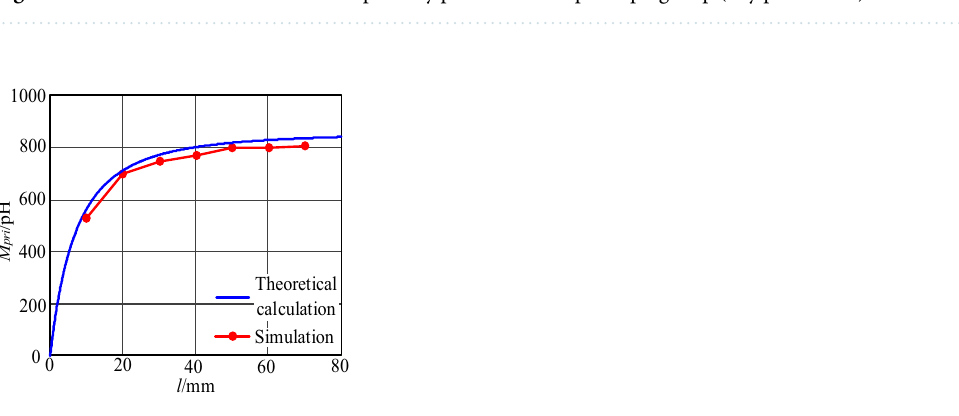
Figure 18. 3D FEA simulation model of primary power PCB loop and plug loop (xoy plane view).